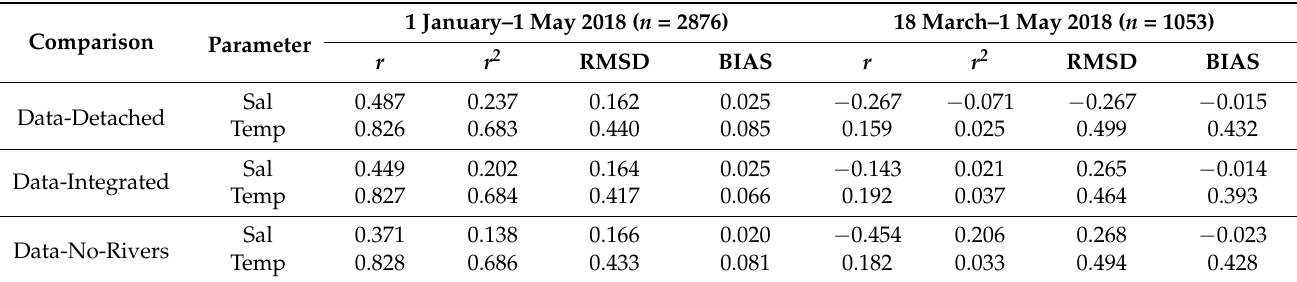
Table 5. Statistical parameters obtained for the validation of the three methodologies against field data (Estaca de Bares moored